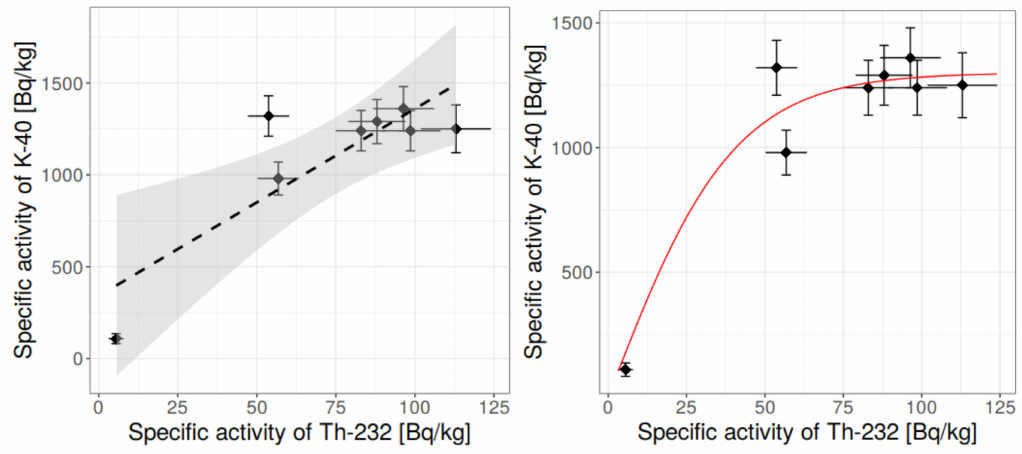
Figure 15. Relationship between specific activity concentration of 40 K and 232 Th in measured granite samples, taking into account the rejection of outliers. Left: linear model with 95% confidence corridor, right: more realistic sigmoidal model (saturation for high concentration of thorium). Determination factor: R 2 = 0.90.